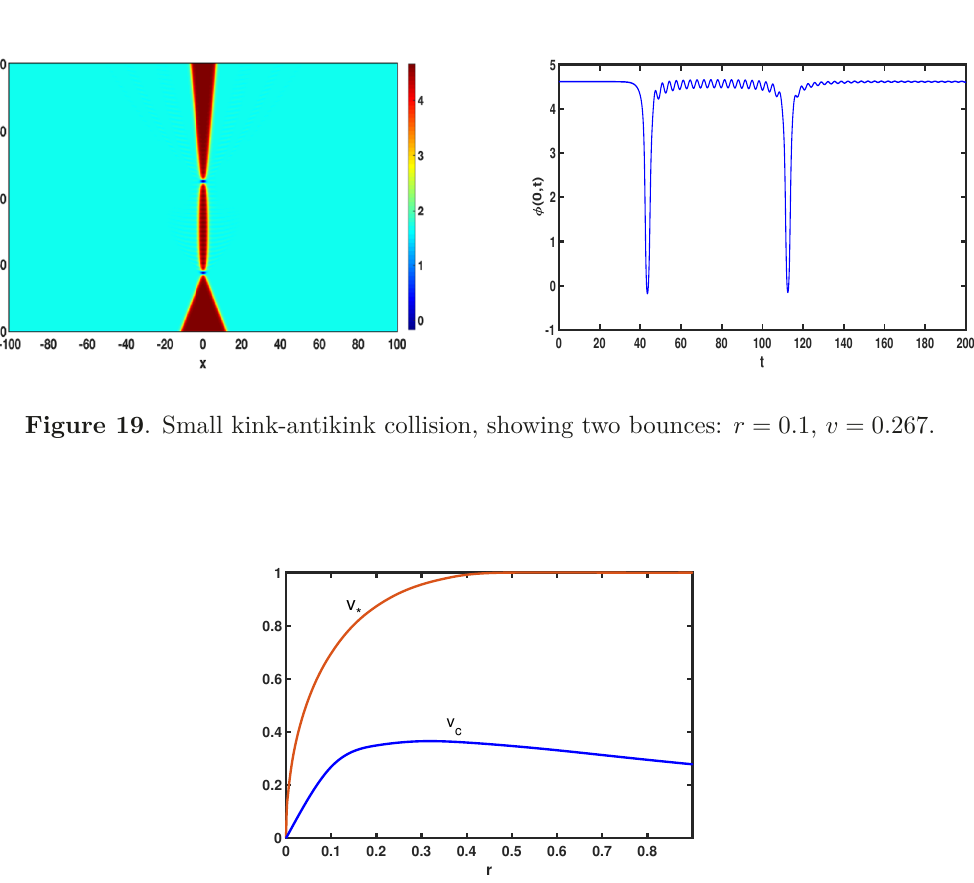
Figure 20 . Small kink-antikink collision: v ∗ and v c as a function of the parameter r . For v > v ∗ there is the changing of the topological sector, with the production of large antikink-kink pair. For v c < v < v ∗ we have one-bounce collision. For v < v c one can have either bion or two-bounce